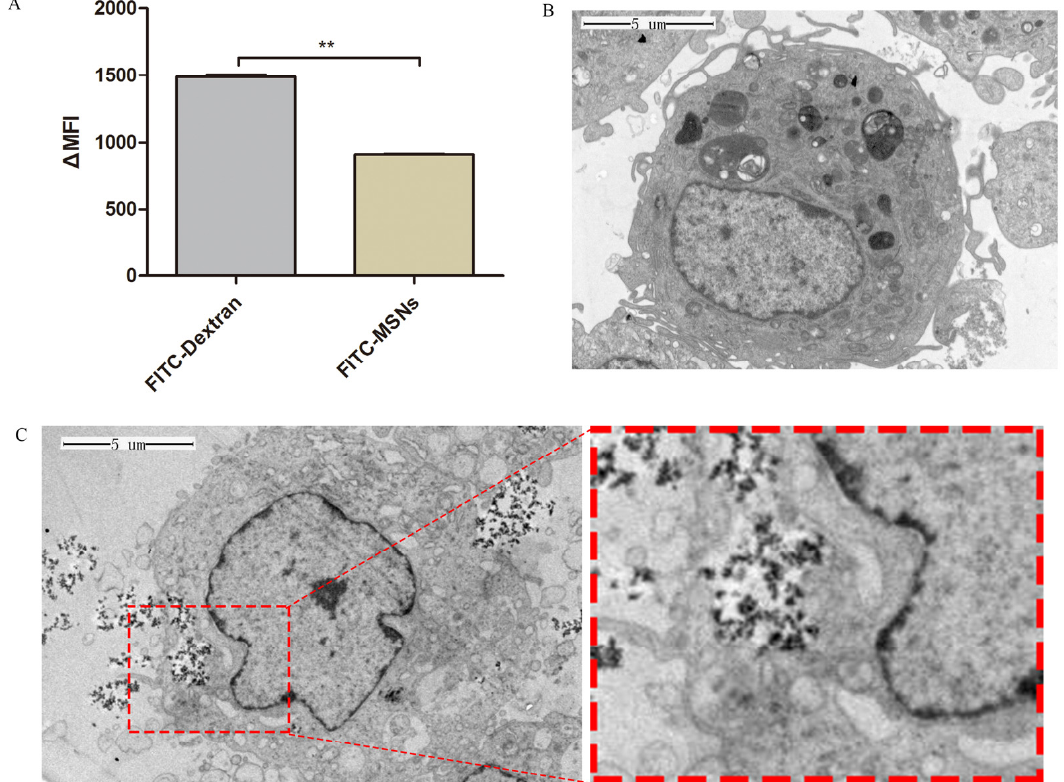
Figure 3. Uptake and intracellular localization of MSNs by im-DCs. ( A ) The phagocytic capacity of im-DCs with FITC-MSNs was detected by flow cytometry. DCs cultured with FITC-dextran as a positive control. MFI were plotted using GraphPad Prism; ( B ) TEM image of DCs untreated as a negative control; ( C ) TEM image of internalization of MSNs in DCs. Data were presented as mean ± SD of three duplicate samples. Differences were considered significant at (**) p < 0.01.